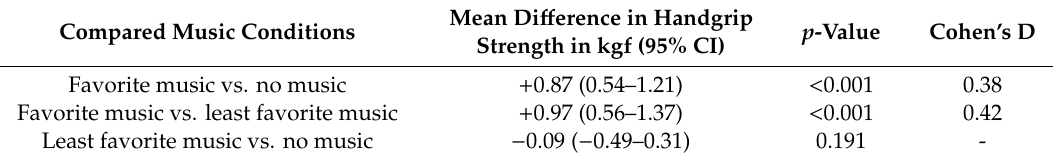
Table 3. Mean di ff erence in handgrip strength related to the type of music.